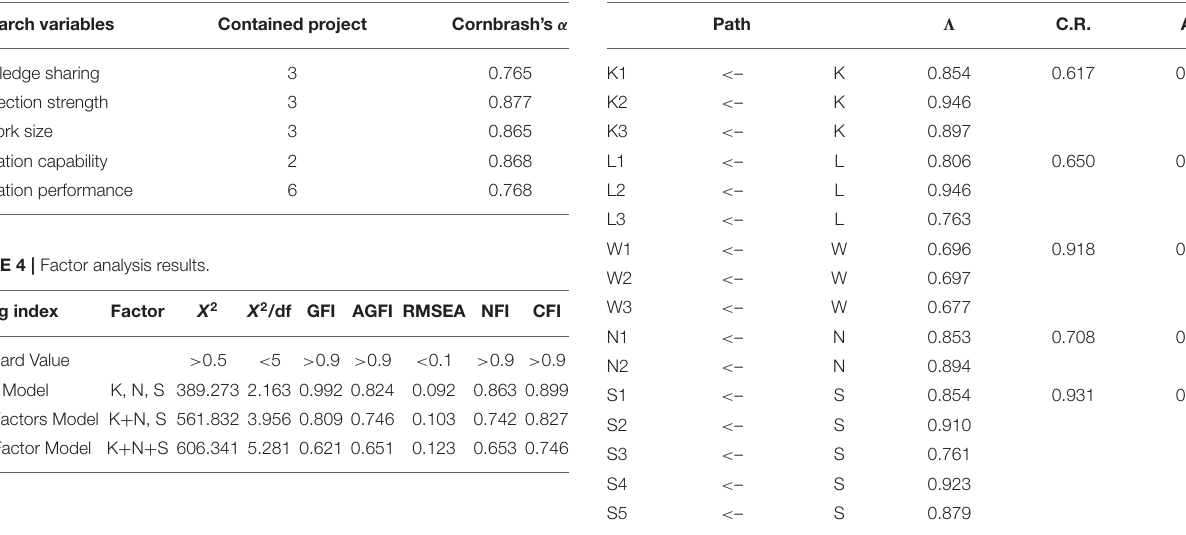
TABLE 3 | Reliability analysis.